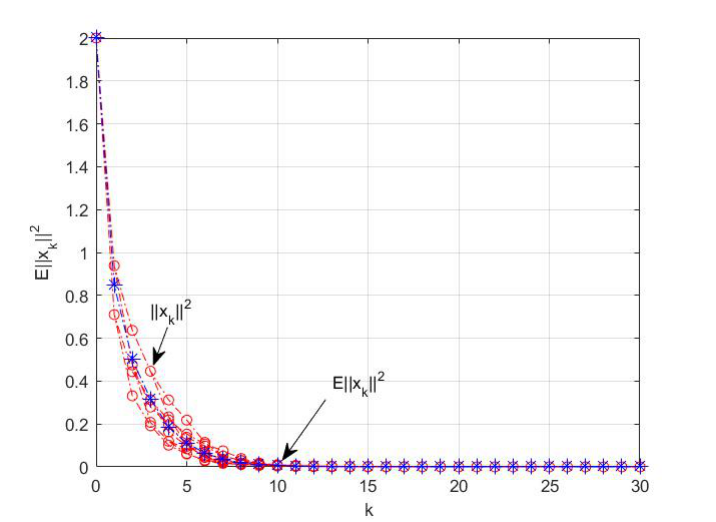
Figure 1. The norm E (cid:107) x k (cid:107) 2 curve of the system state with respect to the iteration step k in Example 1. Next, a system that is not mean-square strongly stable is given, and the design prob- lems of the state feedback controller and output feedback controller are